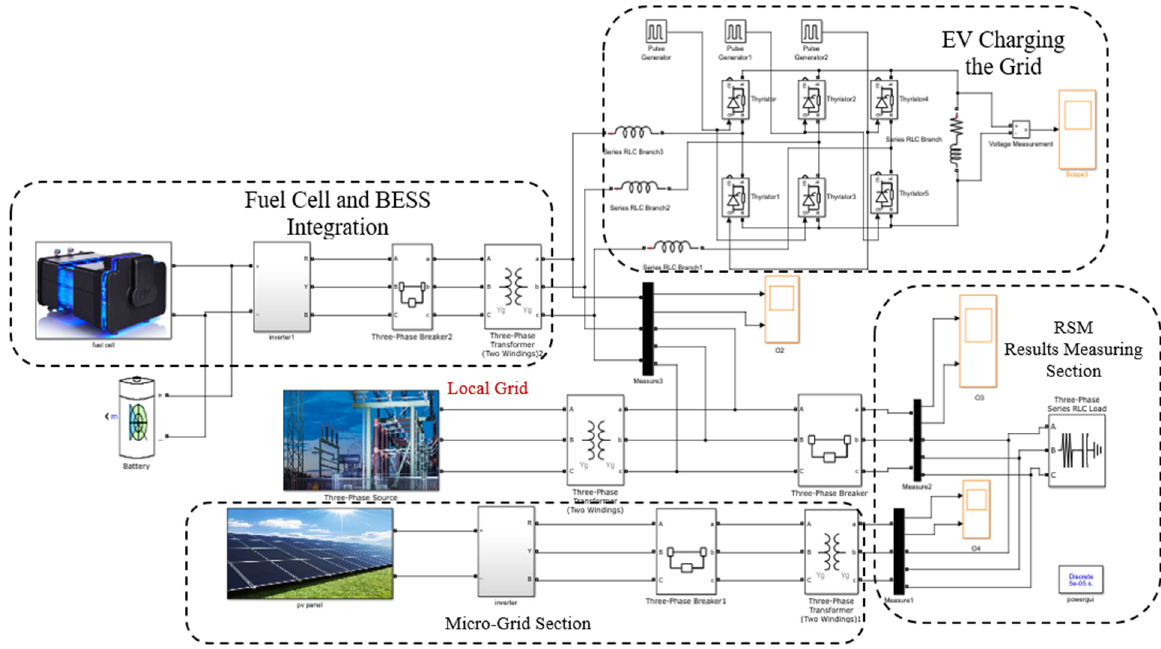
Figure 4. Proposed energy resource management system simulation diagram.